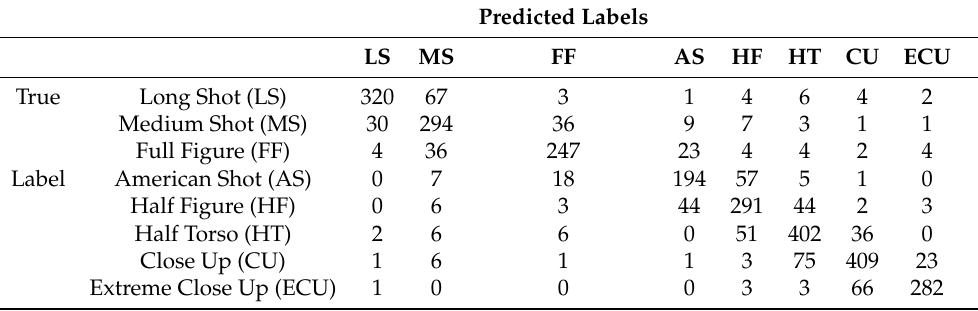
Table 5. Confusion Matrix of the MLP as fourth classifier.